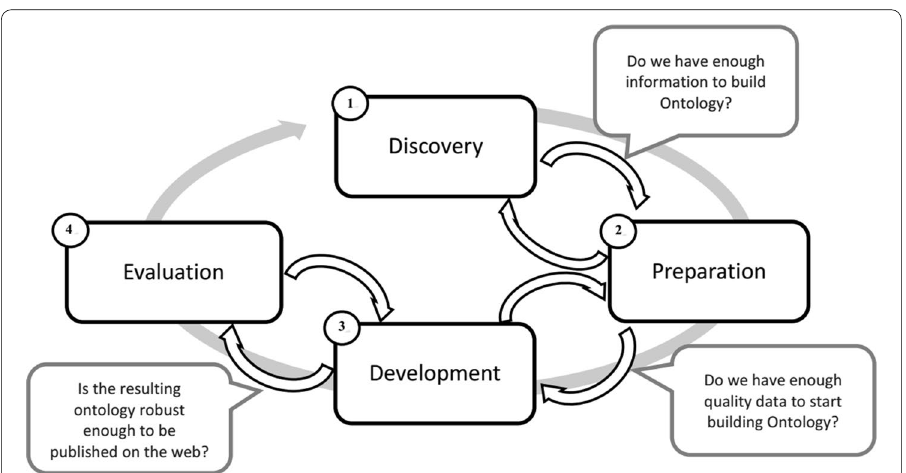
Fig. 1 Life cycle of learning ontologies from relational